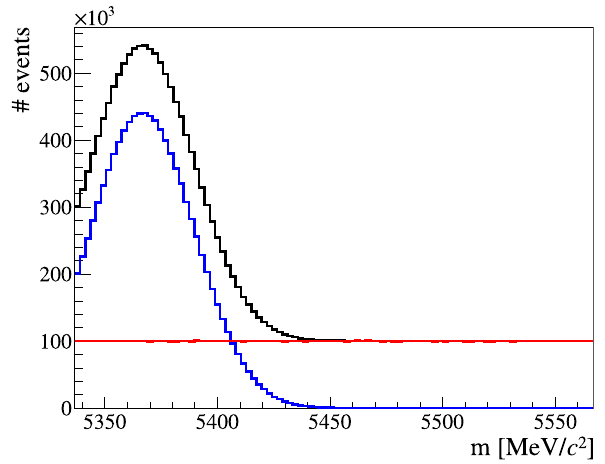
Fig. 6 Discriminatingmassdistributionfor(black)thefulldata,(blue) signal and (red) background